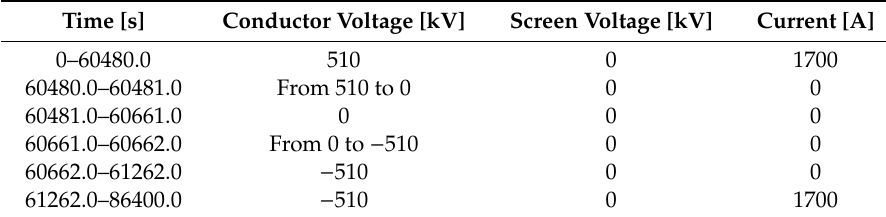
Table 3. Electrical boundary conditions during the simulated transient.